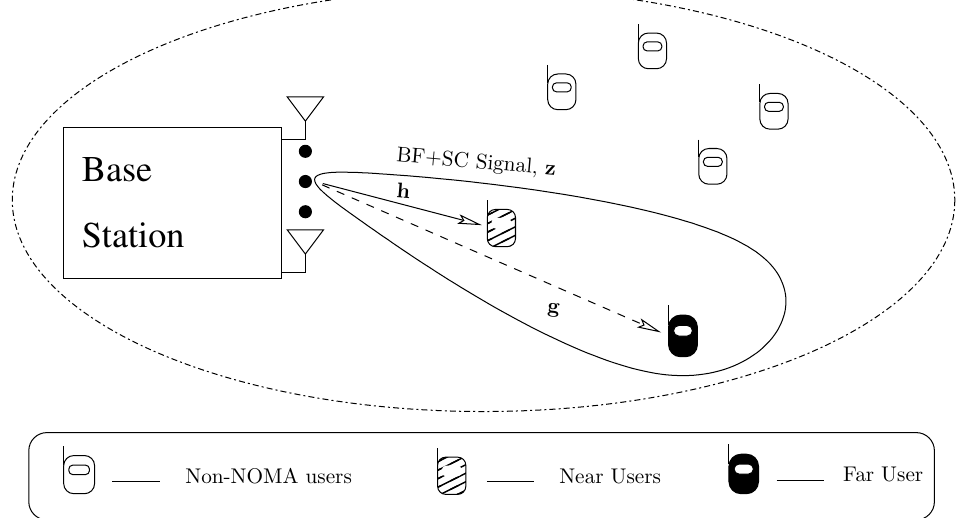
Figure 1. The downlink beamforming plus superposition code (BF + SC) system model